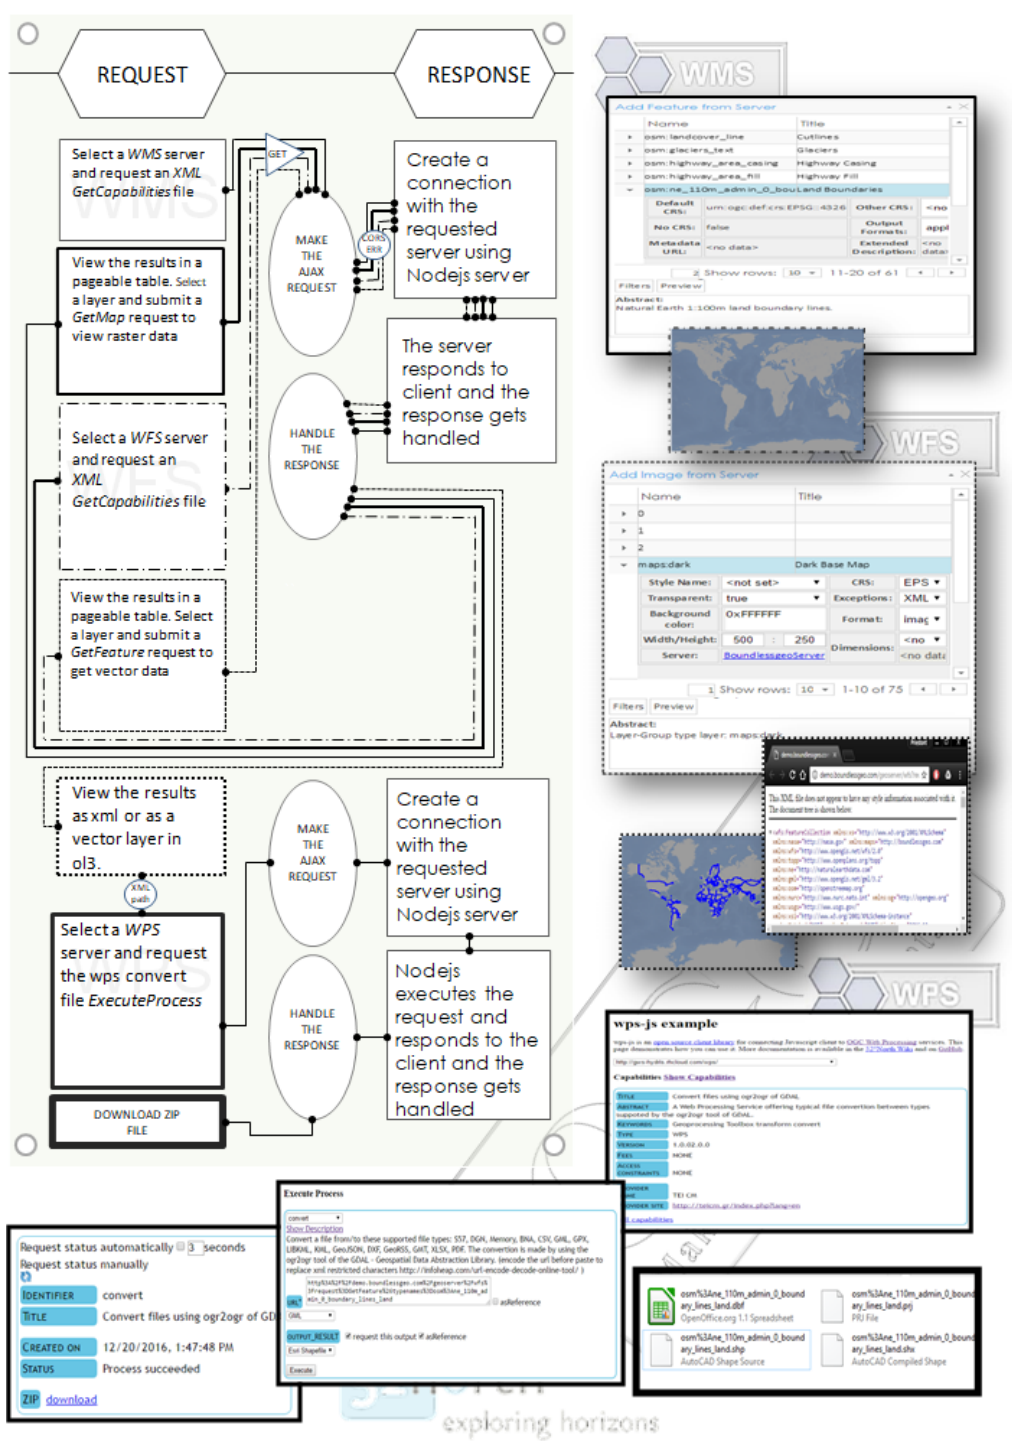
Figure 7. Scenario workflow diagram (demonstrated at goo.gl/f54X6Q).